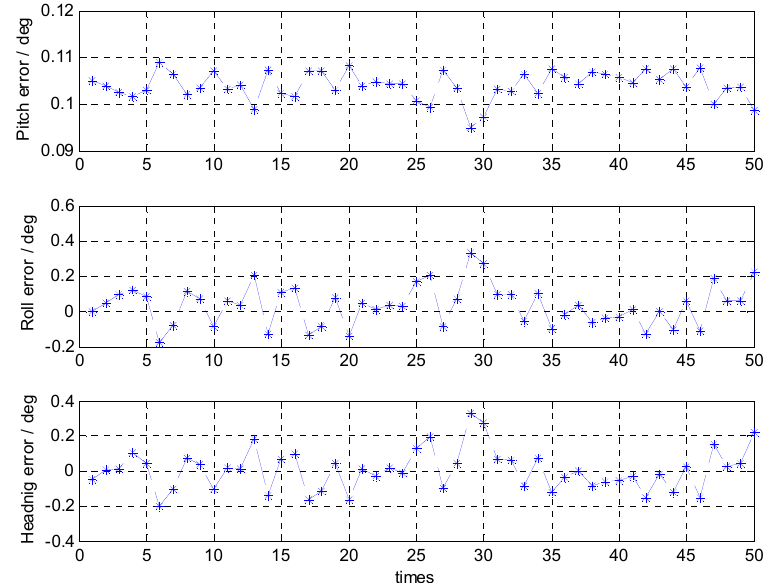
Figure 4. Attitude errors of the coarse alignment with the calm sea condition.